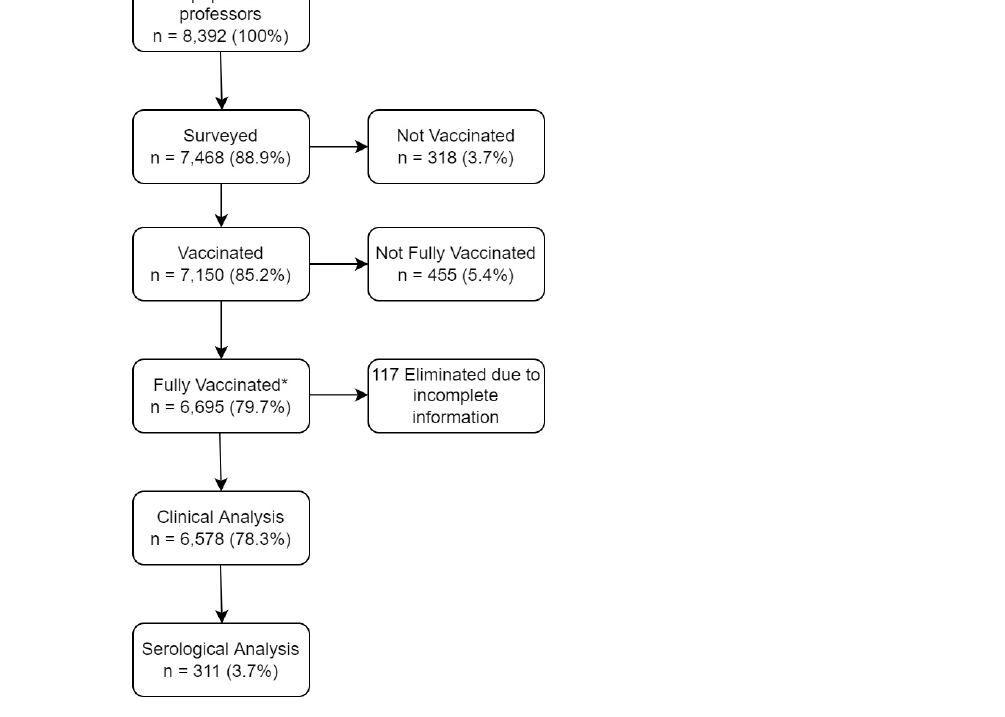
Figure 1. Diagram of the studied population. * Fully vaccinated: those who received a single dose vaccine ≥ 30 days, or those who received a 2 dose-scheduled vaccine and ≥ 7 days after the last dose